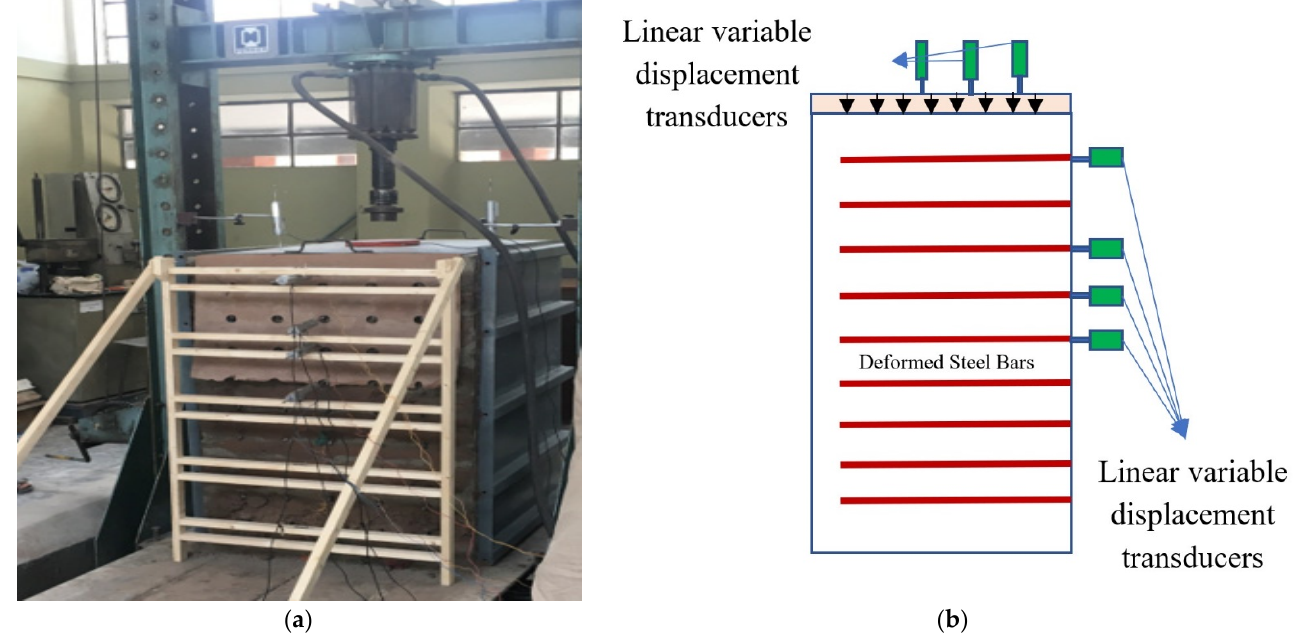
Figure 6. ( a ) Large scale model of MSE along with instrumentation, loading plates, and hydraulic jack; ( b ) Schematic view of MSE wall.